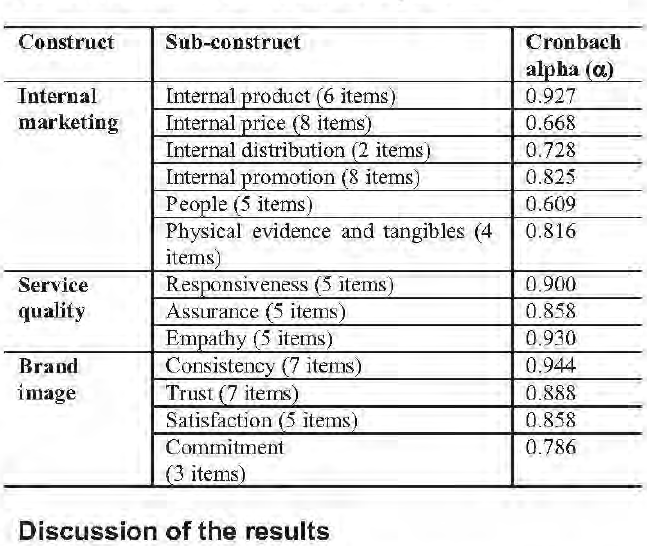
Table 1: Results of the Cronbach alpha